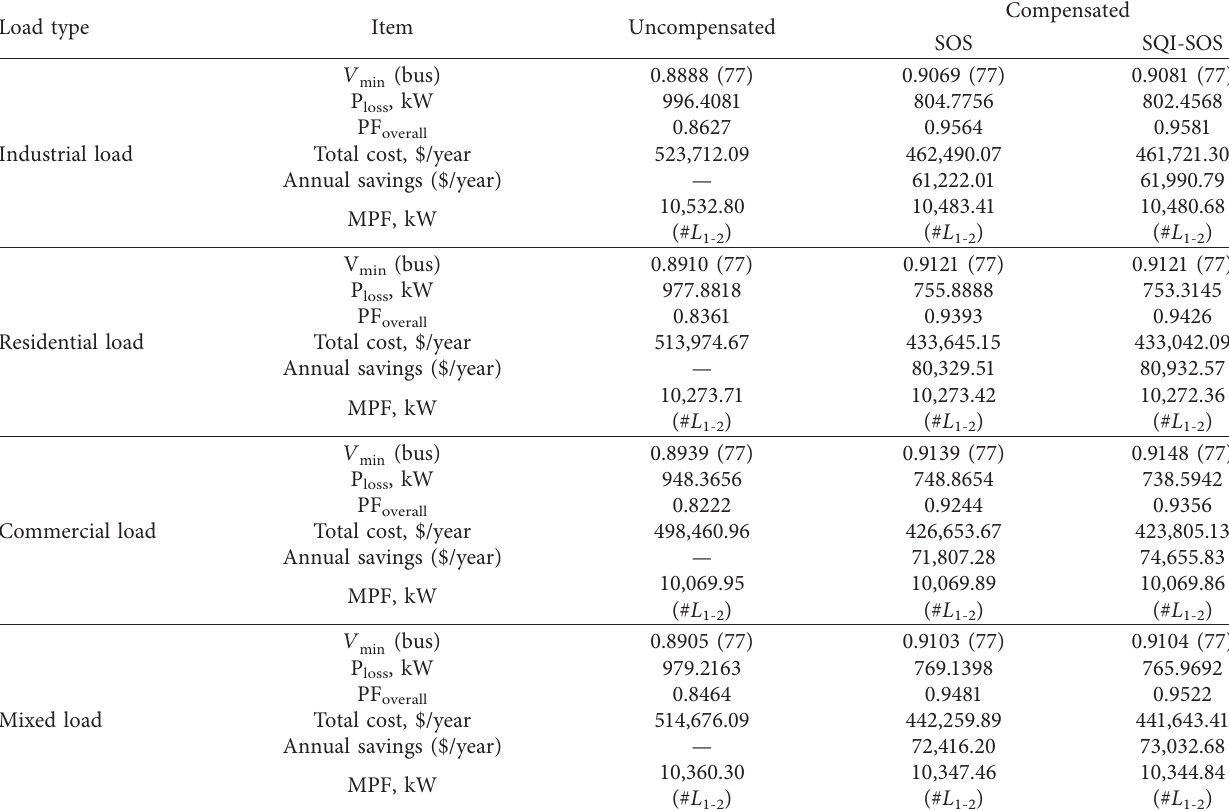
Table 17: Comparative results of the 119-bus system after compensation with the different load models.